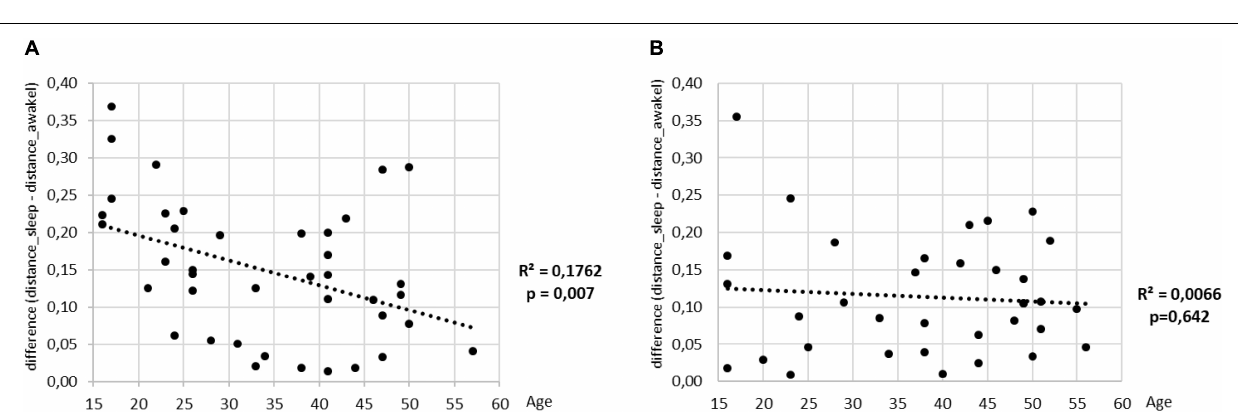
FIGURE 13 | The value of mean distance from the best shapelet for one class minus the mean distance from the best shapelet for the other class (shown on y ) is scatter plotted against the age (plots A for men and B for women). Regression lines are indicated in black, along with the respective values of R 2 and p